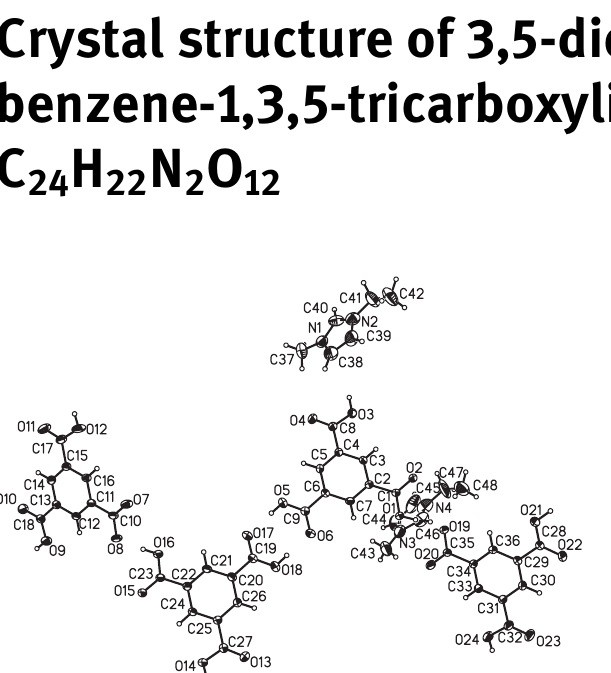
Table 2: Fractional atomic coordinates and isotropic or